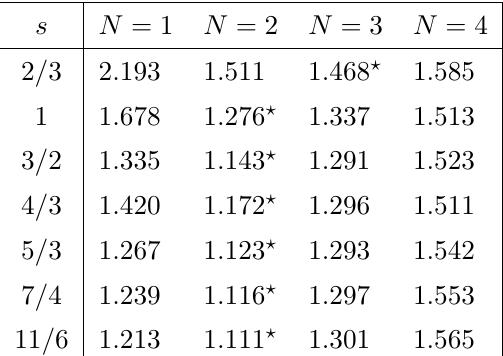
for which N = 3 3